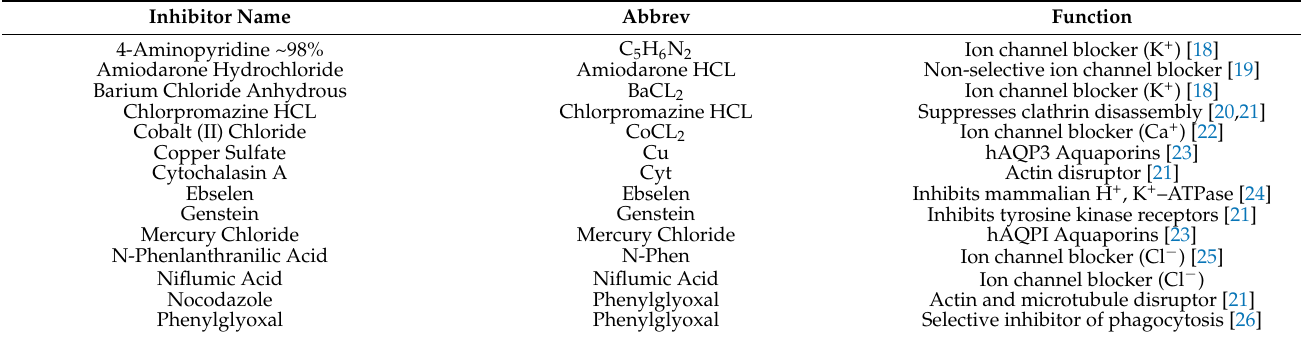
Table 2. Inhibitors used for potential uptake routes of